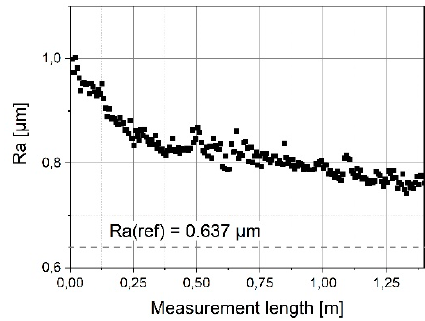
Figure 20. Determined average roughness values for wear measurements on the roughness standard RN6531 for a traverse length of 1.4 m. The dotted line corresponds to the reference roughness Ra = 0.637 µm.